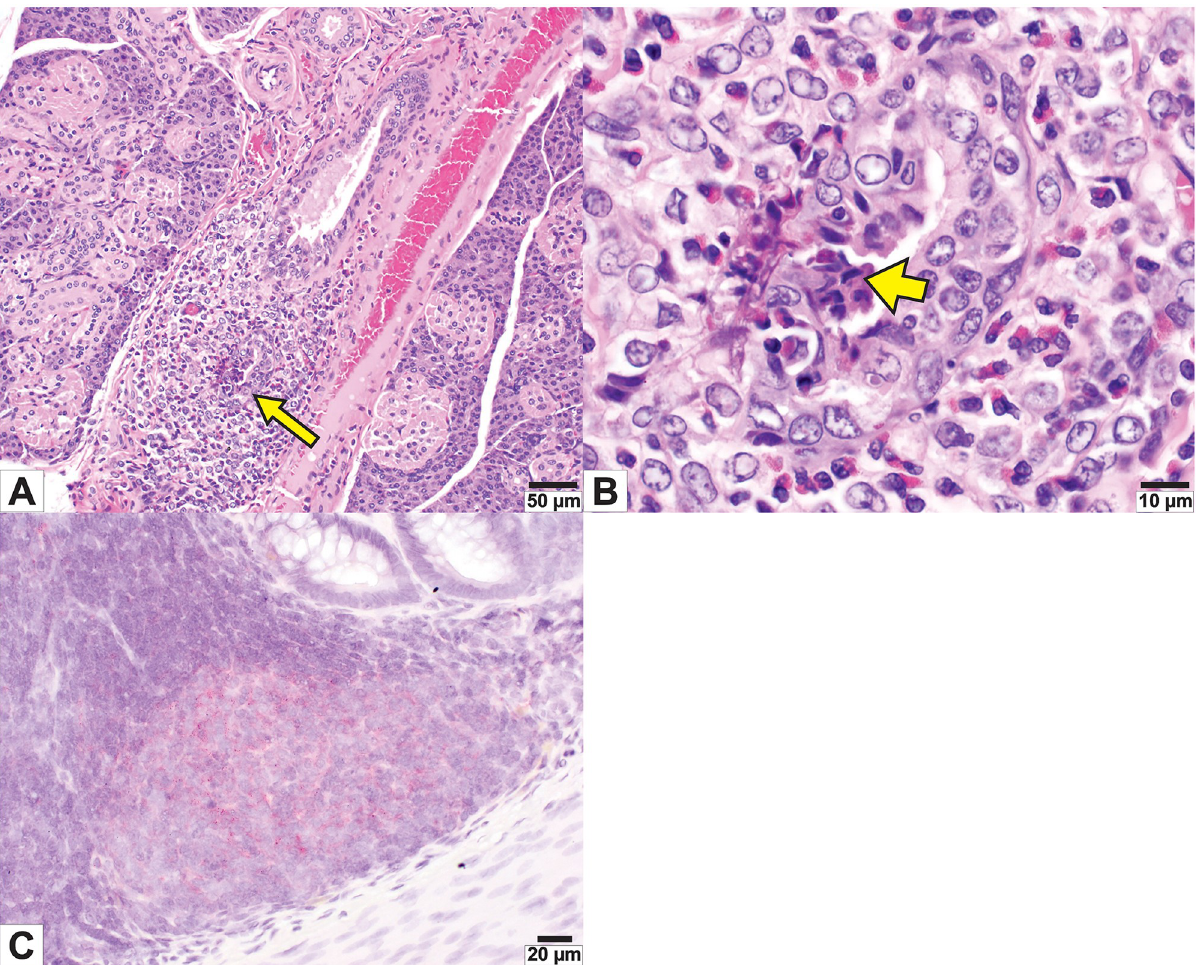
Fig 5. Mild pathologic effects of infection with Sosuga virus in the salivary gland and small intestine of inoculated bats. (A) Low magnification photomicrographs of the salivary gland from a 6-day post-inoculation (DPI) bat (284899) showing marked numbers of granulocytic inflammatory cells surrounding and infiltrating an intralobular duct (arrow). (B) Higher magnification photomicrographs of the same interlobular duct. Multiple ductular epithelial cells exhibit degeneration and few are necrotic, with hypereosinophilic cytoplasm and pyknotic nuclei (arrowhead). This bat was strongly qRT-PCR positive for SOSV in the salivary gland at necropsy (++++) and SOSV was detected in oral swabs at 5 and 6 DPI. (C) Positive hybridization signal for SOSV matrix protein gene (red chromogen) in the large intestinal gut-associated lymphoid tissue (GALT) from bat 289953 hematoxylin counterstain; original magnification